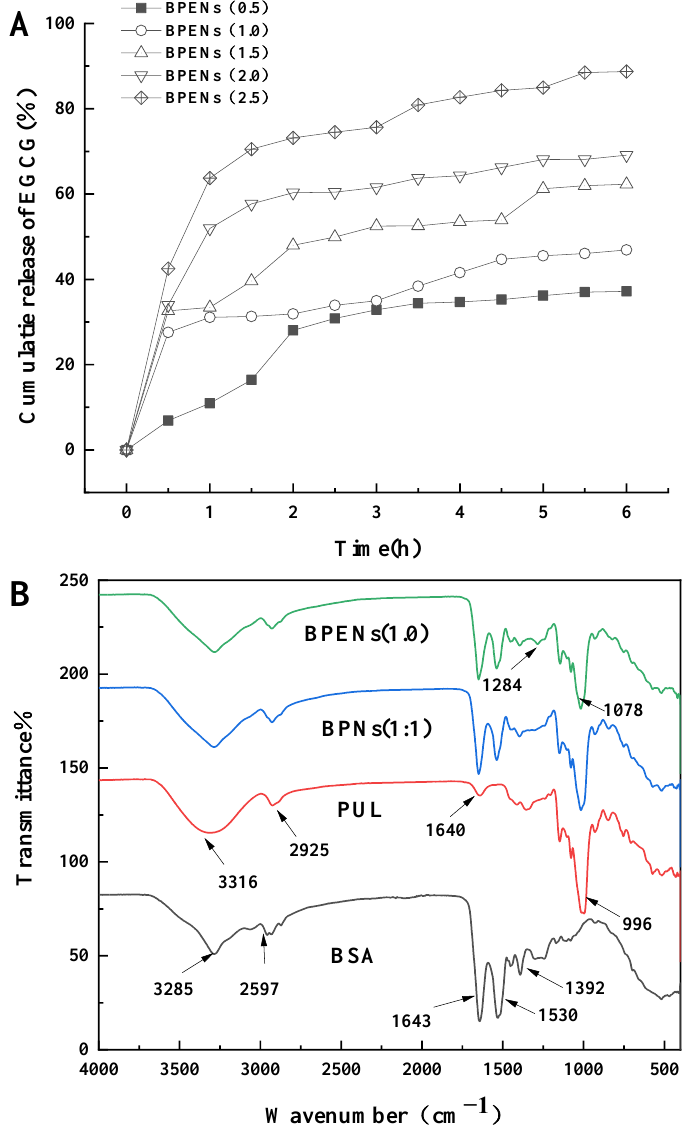
Figure 6. In vitro release curves ( A ) of EGCG and FTIR spectrum ( B ) of BSA, PUL, BPNs, BPENs.